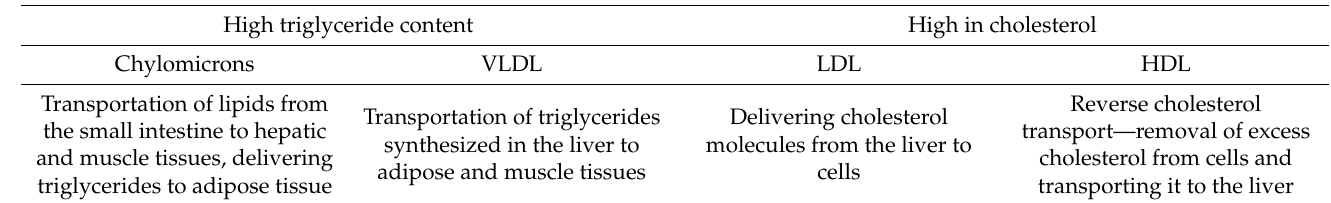
Table 1. Human plasma lipoproteins